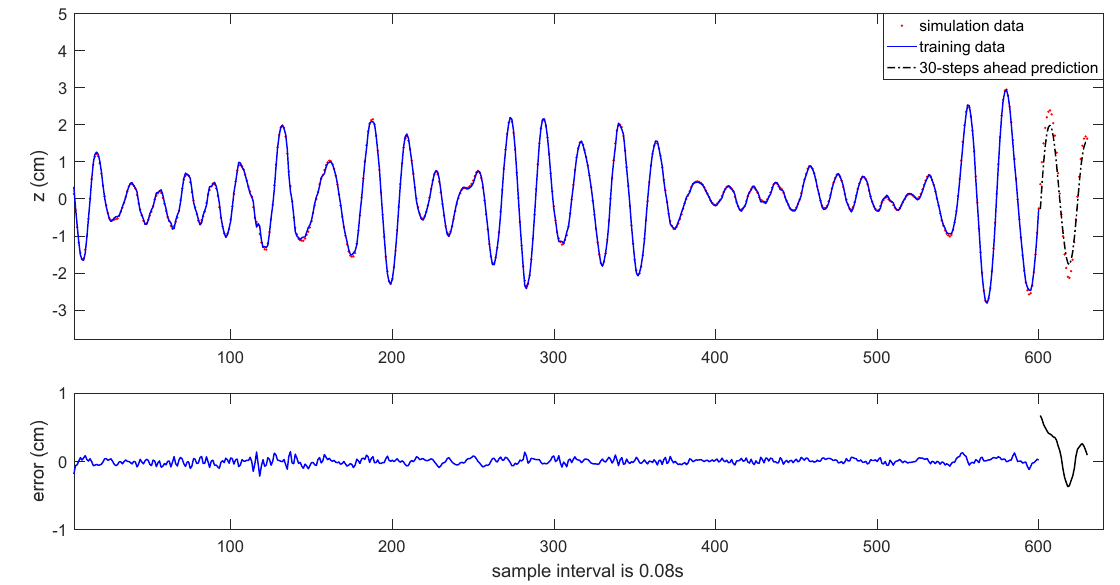
Figure 16. The 30-steps-ahead prediction of heave motion in irregular waves for the FPSO model.